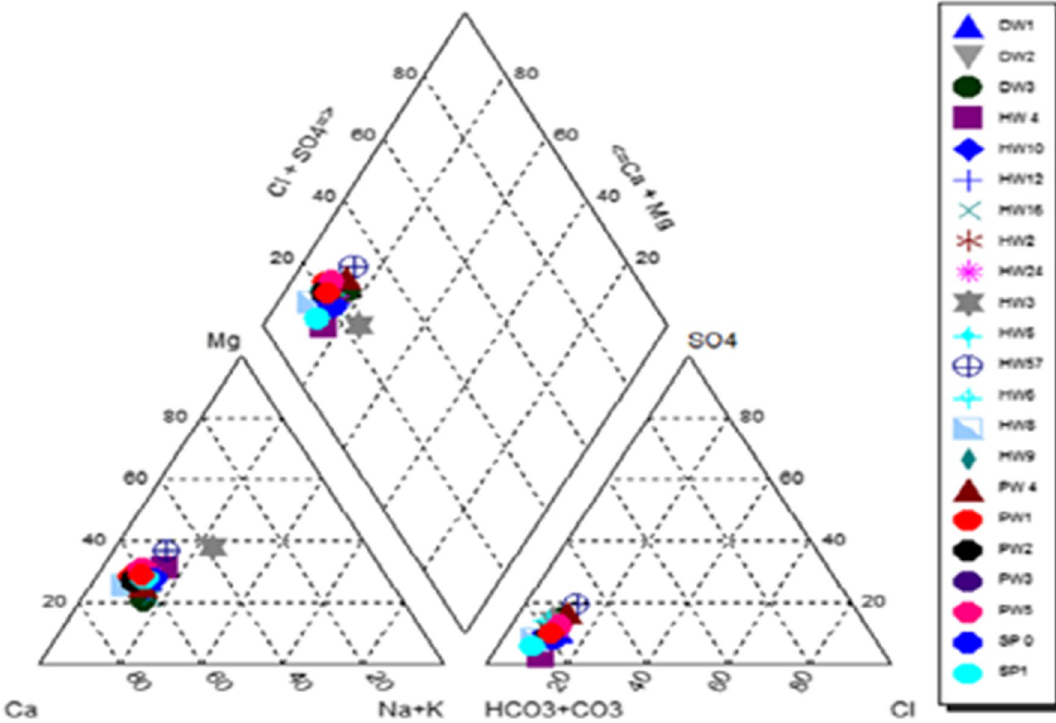
Fig. 6 Piper diagram showing distribution and classification of water types based on major